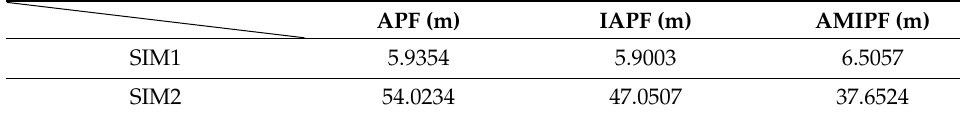
Table 4. Vertical position error (PE).